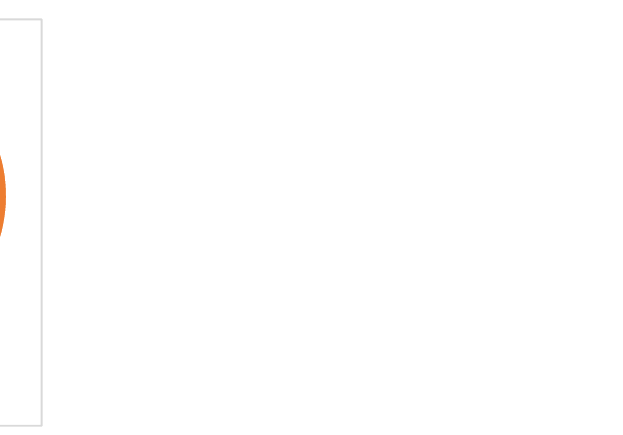
Figure 3. Comparison of mortalities (M) and survival rates (V) during two larvae stages of P. ziziphi (L1V: Surviving larvae of stage 1; L1M: Dead larvae of stage 1; L2V: Surviving larvae of stage 2; L2M: Dead larvae of stage 2). Table 1. Relationship between the different stages of P. ziziphi .